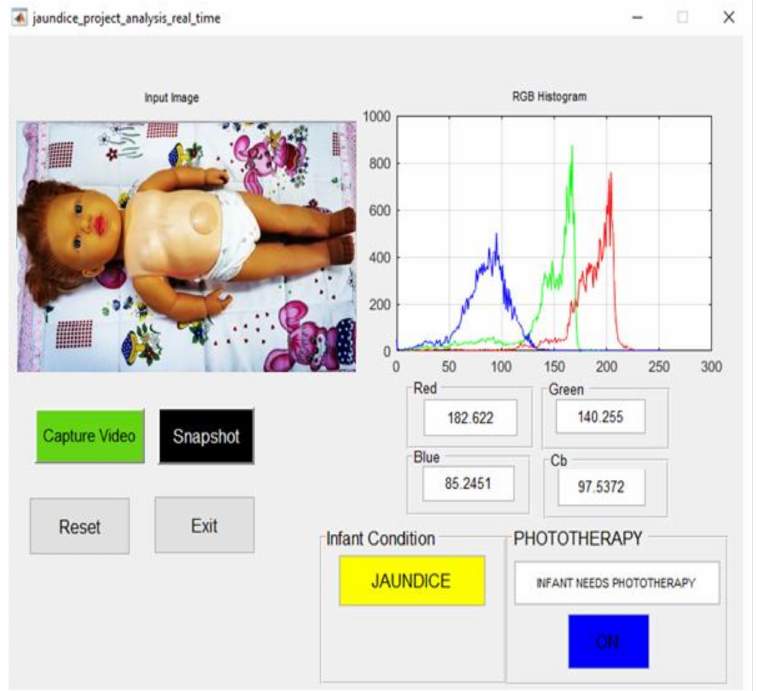
Figure 10. A manikin that has yellowish brown